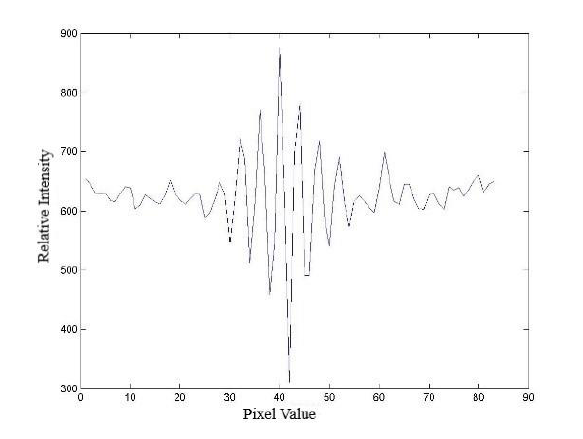
Figure 8. Small bilateral interference